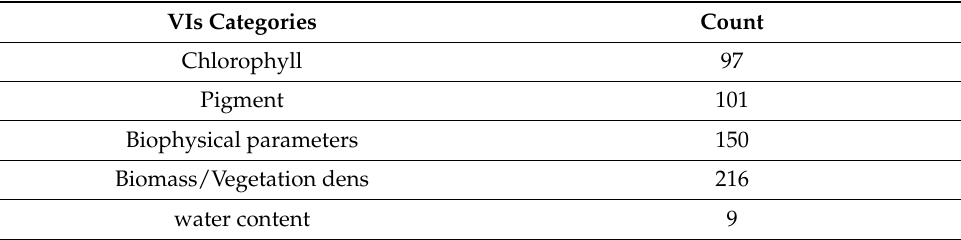
Table 2. Usage of vegetation indices in each